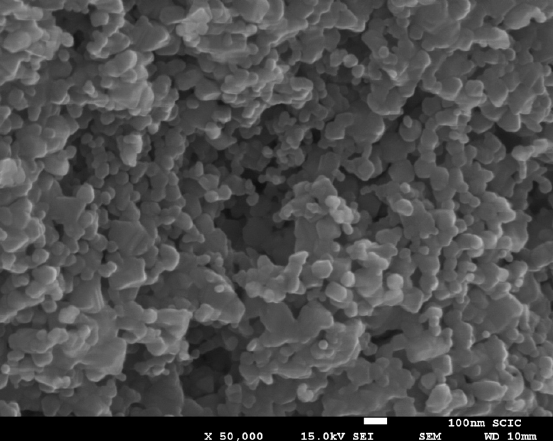
Figure 11. SEM micrograph of sample H-MW2.